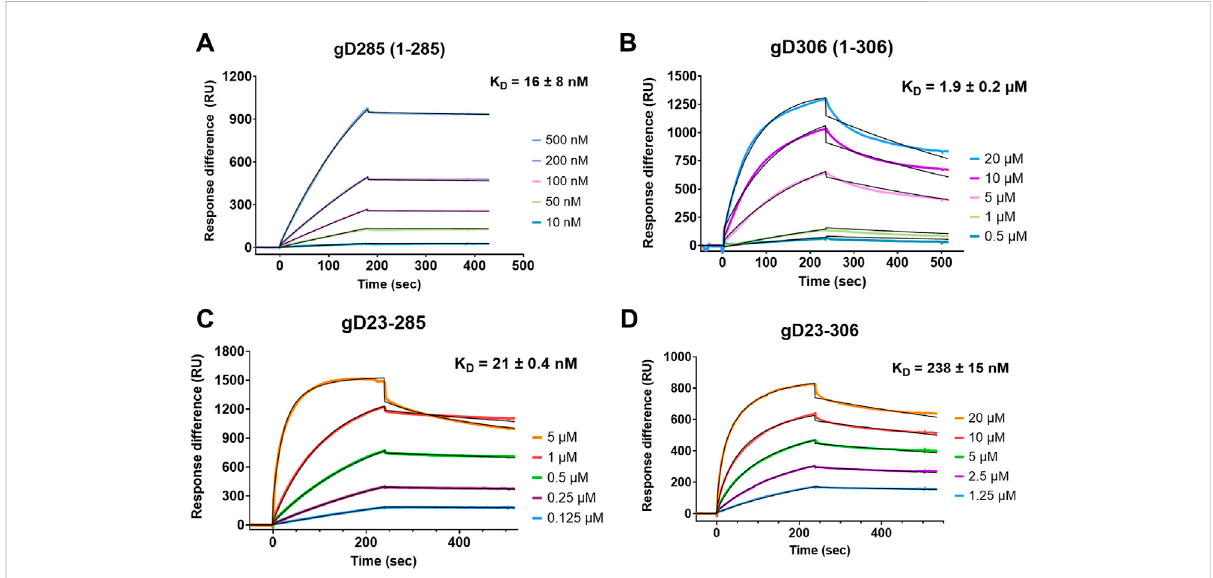
FIGURE 2 The fi rst 22 residues of gD are disposable for heparin binding with gD285 but modulates heparin interaction with gD306. Representative sensorgrams of (A) gD285, (B) , gD306, (C) gD23-285 and (D) gD23-306 to a heparin-immobilized streptavidin chip. Concentrations from top to bottom are (A) 500, 200, 100, 50, 10 nM, (B) 20, 10,5, 1, 0.5 µM, (C) 5, 1, 0.5,0.25, 0.125 µM, and (D) 20, 10, 5, 2.5,and 1.25 µM. The black lines depict the 1:1 Langmuir kinetic model fi t to the raw data. k a , k d , and Χ 2 values are denoted in Supplementary Table